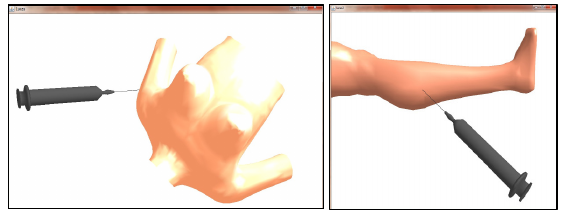
Figure 1. Examples of applications generated by using ViMeT Framework .